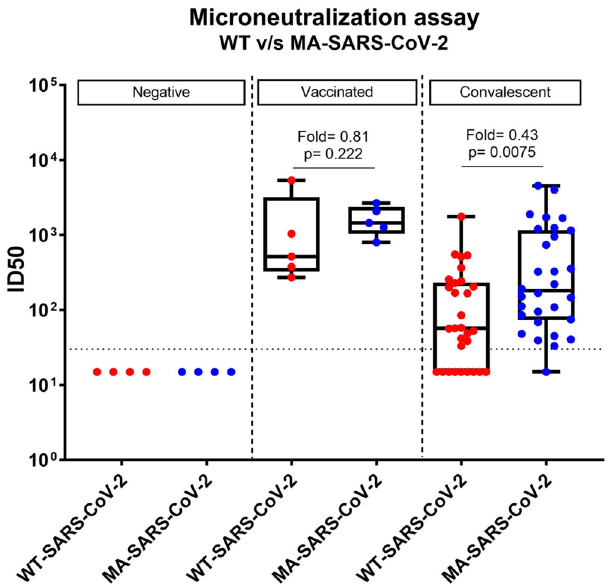
Fig. 8 Post-vaccination or convalescent human sera neutralize both WT- and N501Y/H655Y MA-SARS-CoV-2 viruses. Post-vaccination or post- infection human sera were analyzed for virus neutralization by in vitro microneutralization assays using 450TCID 50 of either WT-SARS-CoV-2 (USA-WA1/2020) or MA-SARS-CoV-2 and the ID50 (inhibition) values were calculated and compared. Each symbol represents ID50 value calculated for a human serum sample [negative ( n = 4) versus weak ( n = 8), moderate ( n = 10), or strong positive ( n = 11)].Sera from sero-negative individuals were used as negative control for the experiment. Dotted line (LOD). Two-sided Mann – Whitney U test was performed to calculate the statistical signi fi cance (p) between different groups. The box-whisker plots show all minimum to maximum data points, with respective medians and interquartile range. Source data are provided as a Source Data fi le.